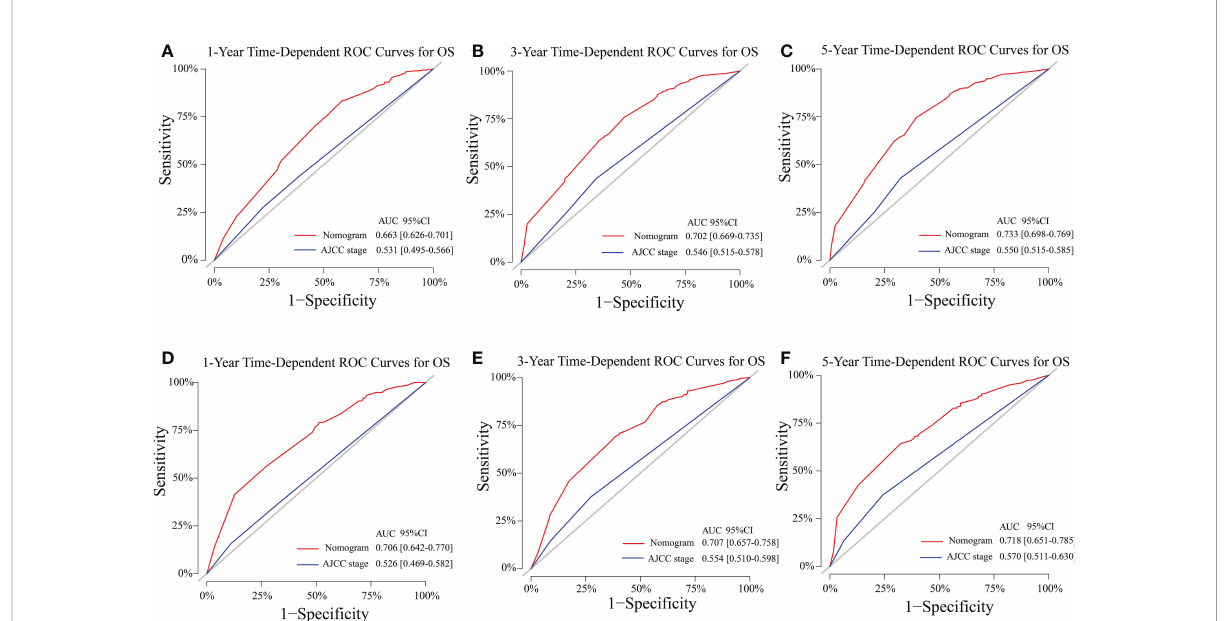
FIGURE 3 Model performance of the proposed nomogram. (A – F) Time-dependent ROC curves of the two prognostic models for predicting 1-, 3-, and 5-year OS. The AUCs of the two prognostic models at each time point of interest were presented in the training (A – C) and validation cohorts (D – F) . ROC, receiver operating characteristic; AUC, area under the curve; OS, overall survival; AJCC, American Joint Committee on Cancer; CI, con fi dence